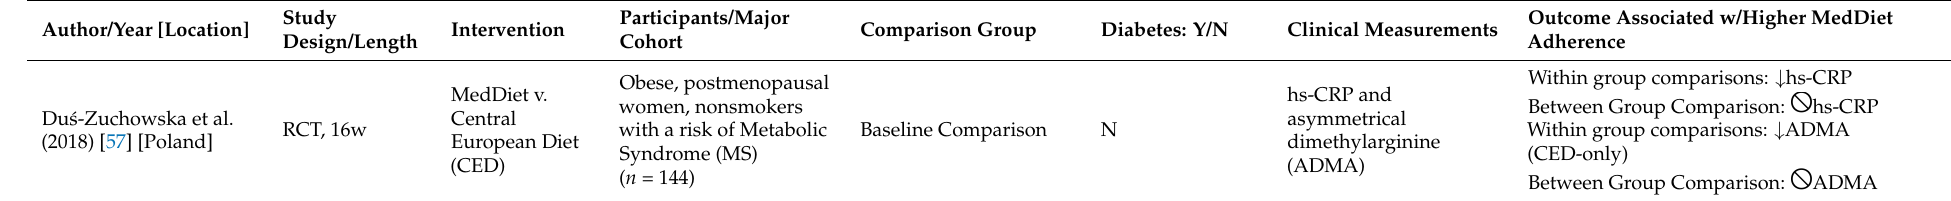
Table 2. Clinical Studies.